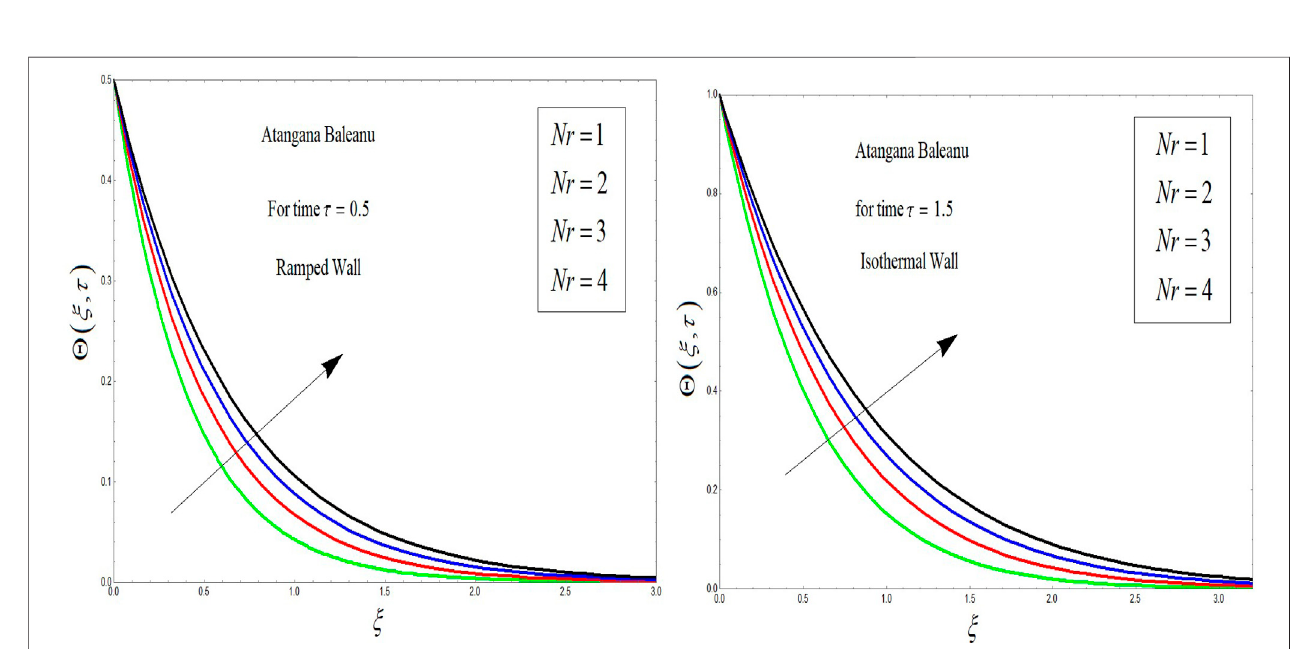
FIGURE 10 | Impact of Nr on temperature (AB fractional